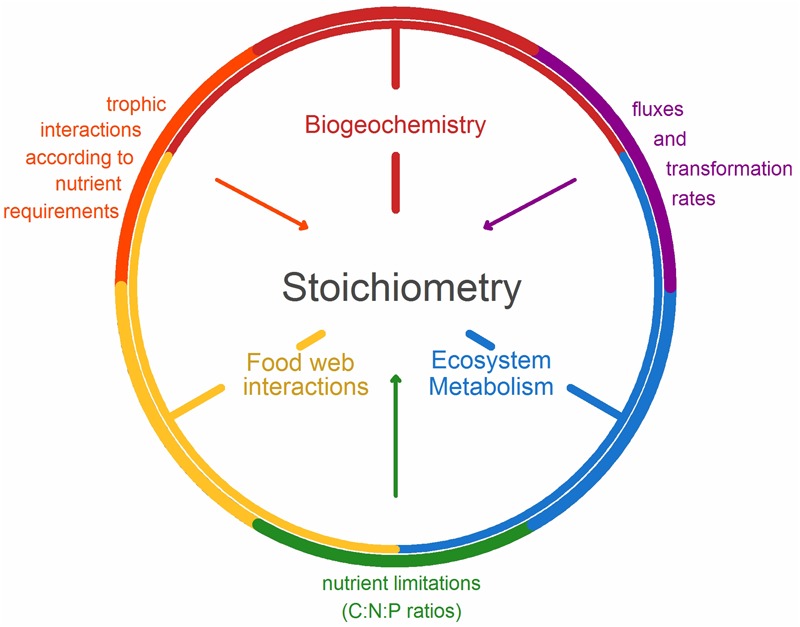
Conceptual framework demonstrating the connection between biogeochemistry, food web interactions, ecosystem metabolism, and stoichiometry. Biogeochemistry and food webs are linked through trophic interactions according to nutrient requirements between trophic levels, food webs, and ecosystem metabolism according to the nutrient limitations (C:P or C:N ratios), and ecosystem metabolism and biogeochemistry through fluxes and transformation rates.